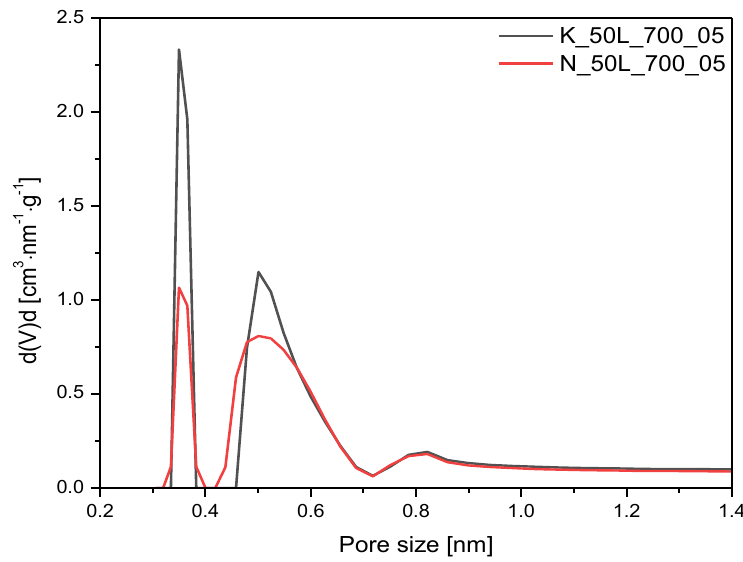
Figure 8. PSD of the samples activated using different chemical activator. The influence of the temperature and time of the activation process on the ultrami- cropores volume was also investigated, and the PSD of the obtained samples is given in Figure 9. An increase in temperature from 700 ◦ C to 750 ◦ C, and even 800 ◦ C, caused an increase in total pore volume in the following order: 0.35 cm 3 /g < 0.37 cm 3 /g < 0.48 cm 3 /g. Although the highest TPV was achieved at 800 ◦ C, the increased contribution of ultramicro- pores V s with dimensions smaller than 1.0 was not observed and the overall Vs content slightly increased, from 0.25 cm 3 /g for K_50L_700_05 to 0.27 cm 3 /g for K_50L_750_05 and 0.28 cm 3 /g for K_50L_800_05. Furthermore, extending the activation time from 5 min for sample K_ 50L_700_05 to 60 min for sample K_50L_700_60, keeping temperature constant, resulted in a slight development in V s volume. It can be concluded that the proper choice of activation temperature more strongly affects this than the exposure length of the sample at that temperature.